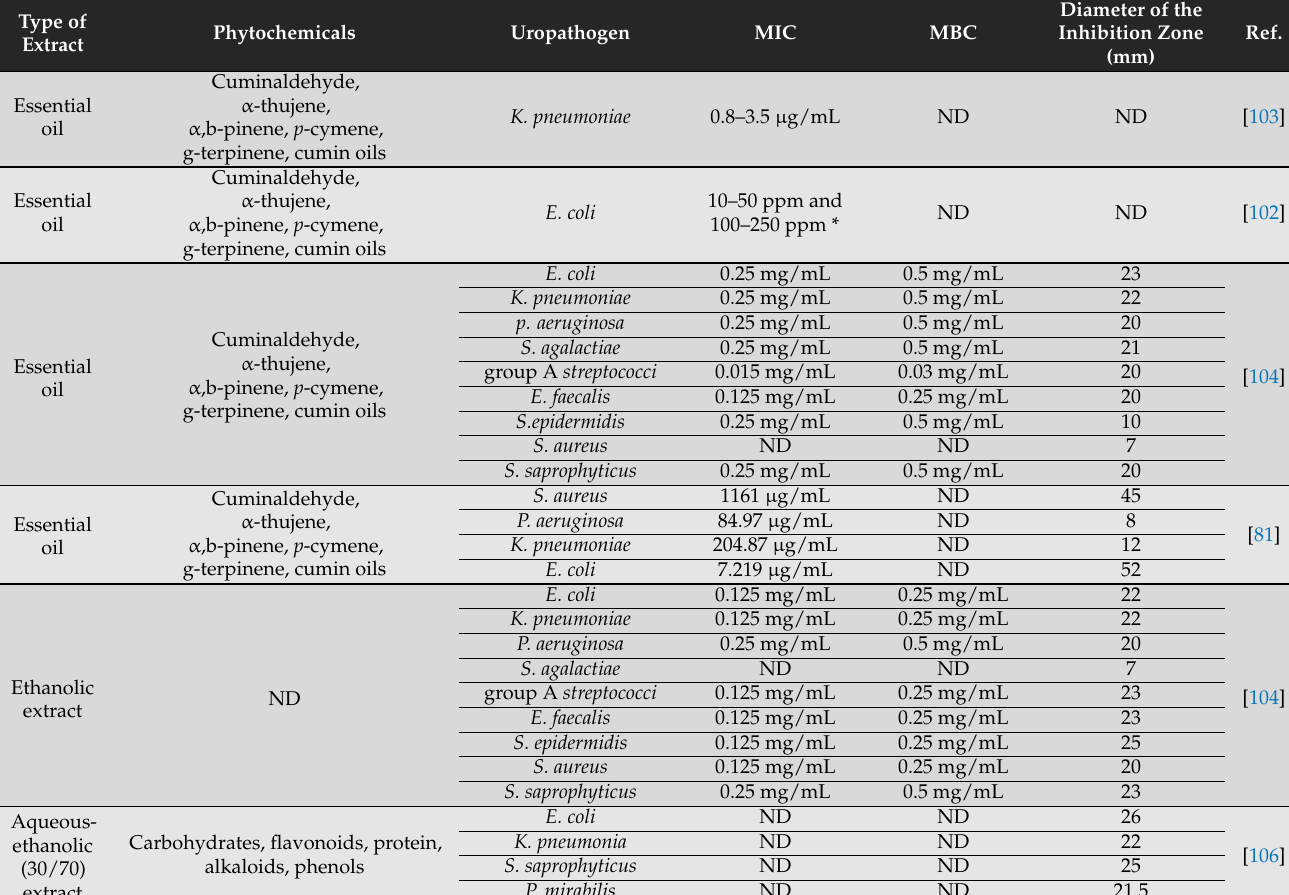
Table 3. Antimicrobial activity of Cuminum cyminum